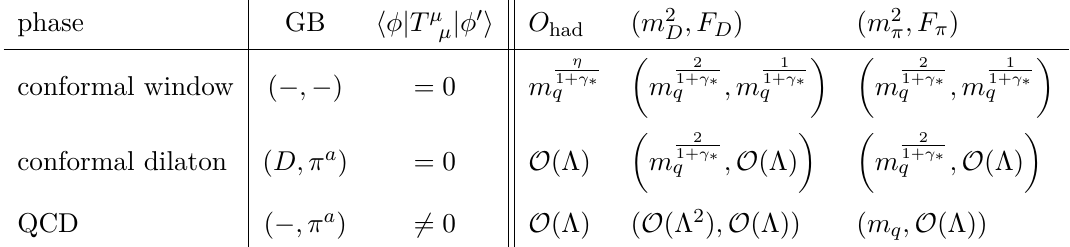
Table 2 . Comparison table between the three different phases discussed in this paper. GB stands for Goldstone boson. The states in the second column are physical states and zero quark mass is assumed. The columns three to five indicate the scaling when a quark mass is turned on. Above O had is a generic hadronic observable and the conformal window scaling law has been discussed in (3.1). and the masses and the decay constant for the Goldstone boson singled out in the least two columns. The notation is the as in table 1 where further information on excited states in the conformal dilaton phase can be